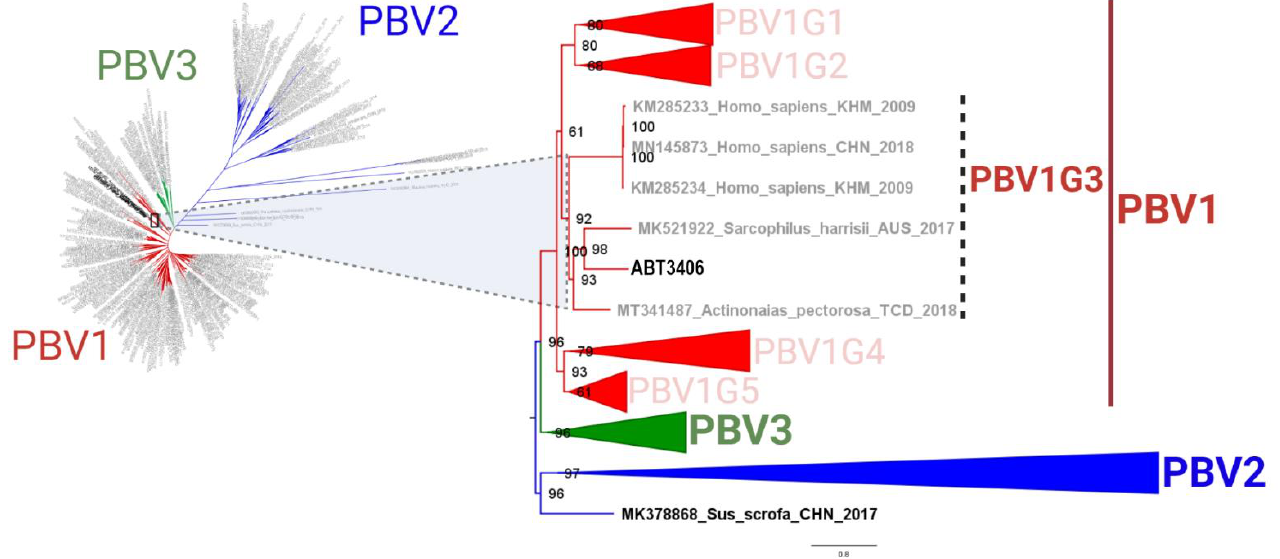
Figure 2. RdRp of ABT3406 branches with other respiratory PBV strains (left panel). Phylogenetic tree based on the complete deduced amino acid sequences of PBV RdRp from the index case (ABT3406) and 403 non-redundant genomes available in GenBank. The maximum likelihood (ML) method with an LG+F+R10 model was used and the main lineages for the three PBV species are denoted by colors (PBVR1: red, PBVR2: blue, and PBVR3: green), and collapsed (except PBVR3) for visualization purposes (right panel). Phylogenetic relationship between ABT3406 and other PBV viral strains linked to respiratory disease in humans all cluster together into genotype 3 of PBVR1.